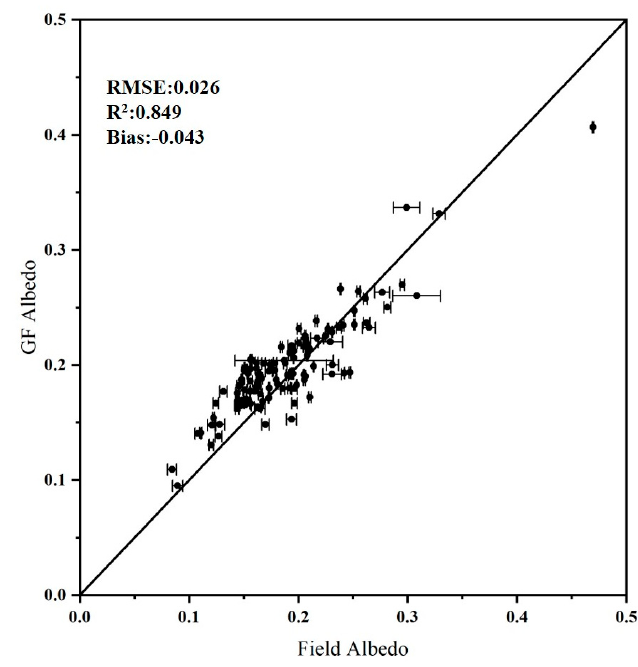
Figure 2. Validation against ground measurements.